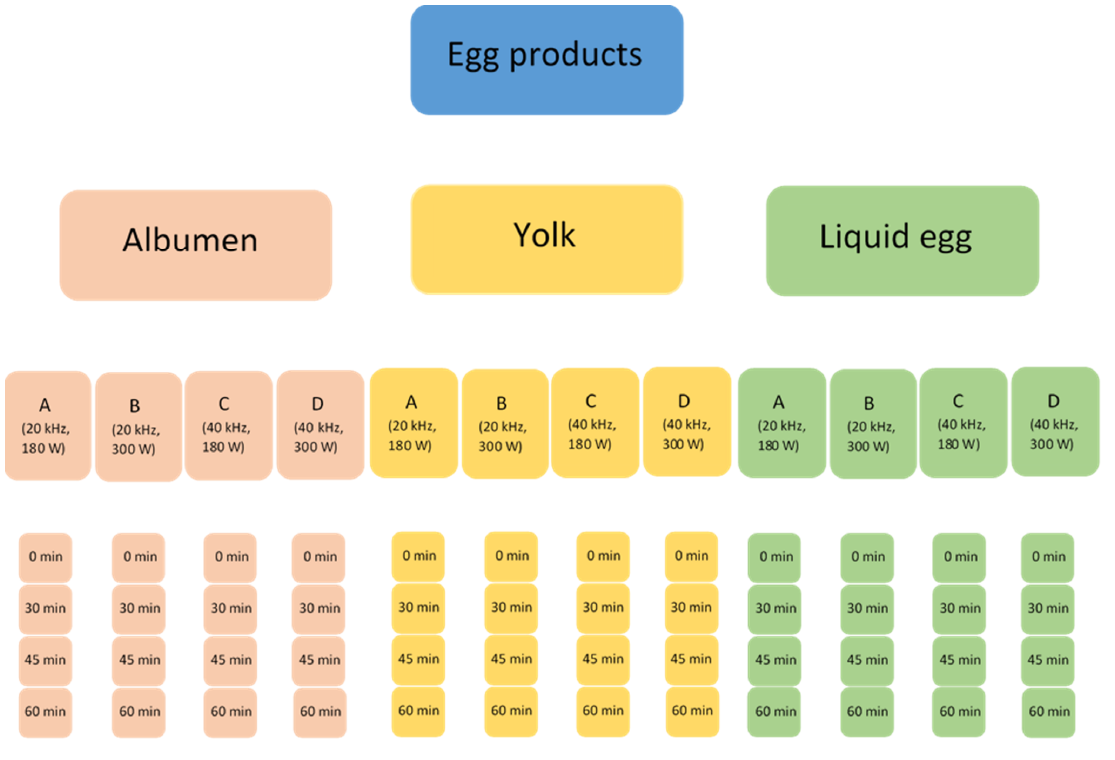
Figure 1. Treatment groups.